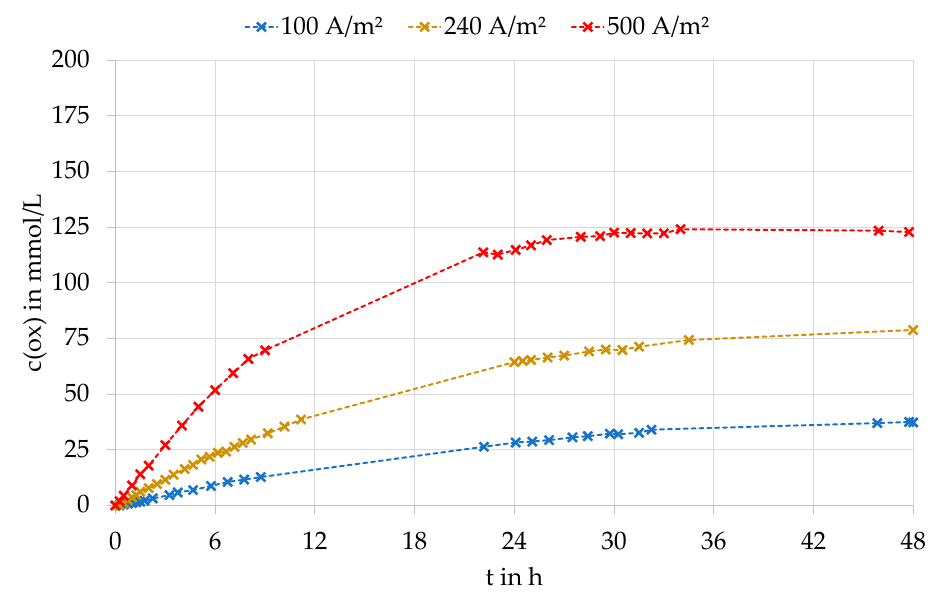
Figure 7. Progression of the concentration of anodically formed oxidants (c(ox)) (one-electron- transition assumed), depending on the current density during electrowinning with a diamond anode at 40 °C.